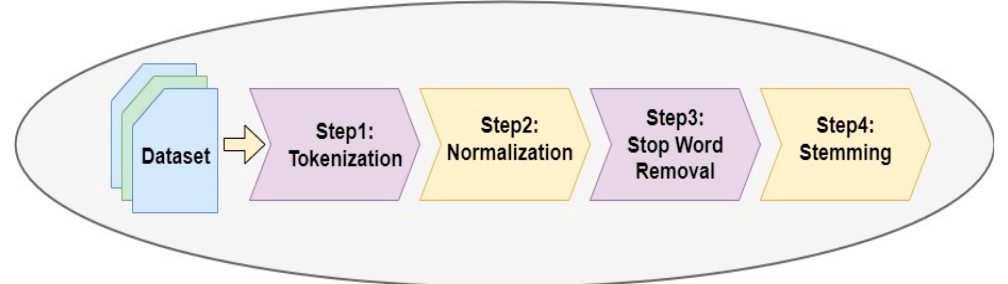
Figure 2. Main pre-processing steps.